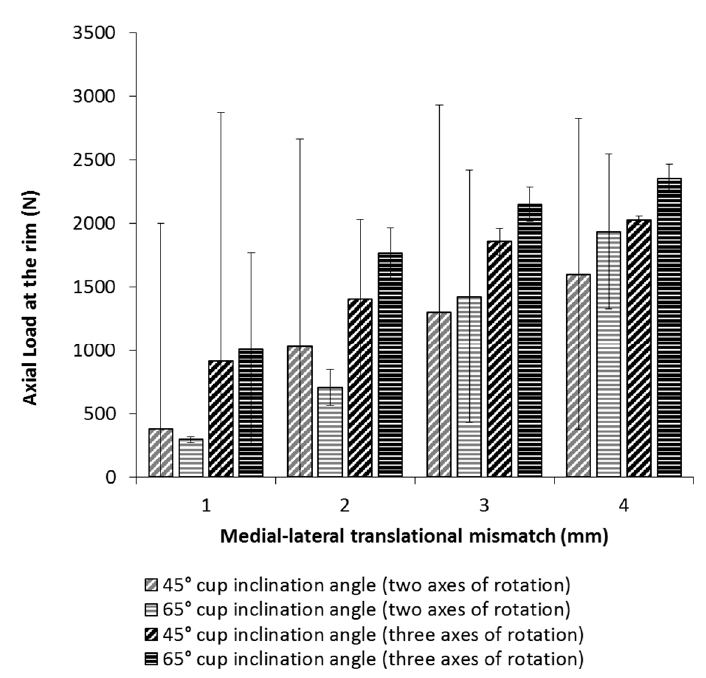
Figure 5. Load at the rim at 0.1 mm of dynamic separation (mean ± 95% confidence limits, n = 3) of 36 mm diameter BIOLOX ® delta ceramic-on-ceramic bearings under two axes and three axes of rotation conditions at 45 ◦ and 65 ◦ cup inclination angles with 1, 2, 3 and 4 mm of medial-lateral translational mismatch.